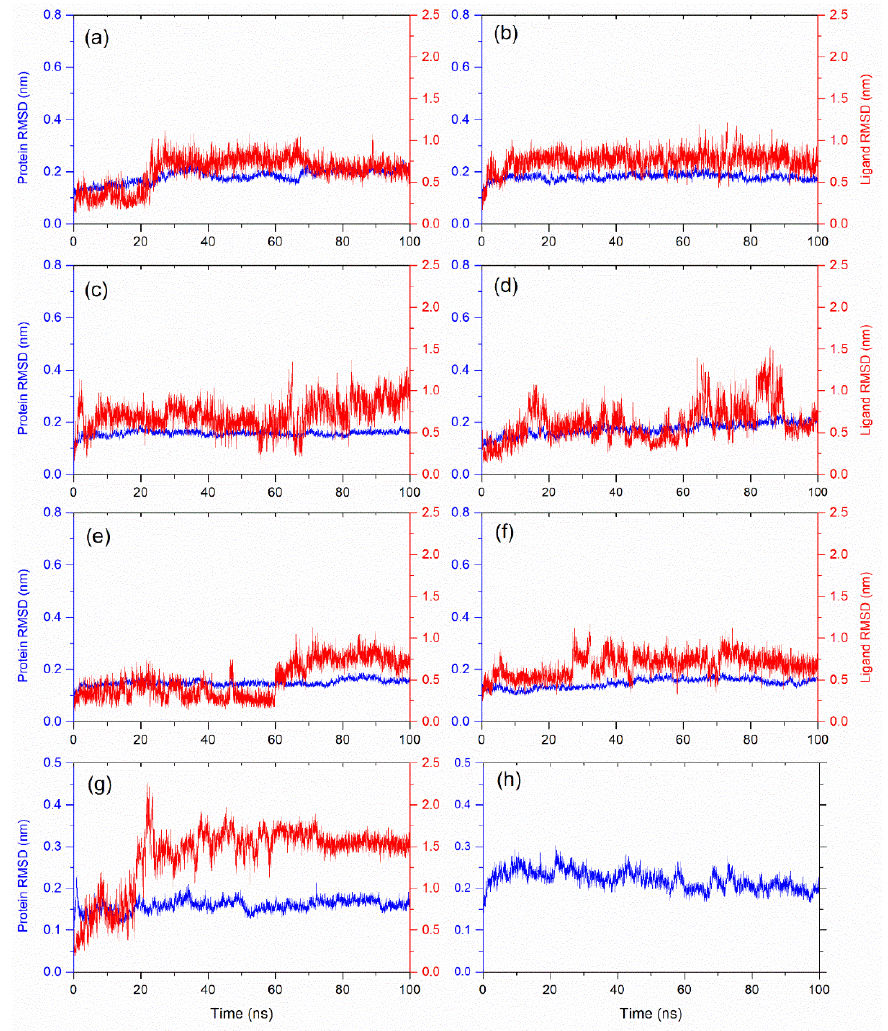
Figure 2. Root mean square deviation (RMSD) of protein and ligand for the docked poses obtained from 100 ns MD simulation for ( a ) Catechin 3,7,-Di- O -Galate, ( b ) Catechin 5,7,-Di- O -Gallatec, ( c ) Catechin 5,4 ’ -Di- O -Gallate, ( d ) Epifisetinidol-(4beta->8)-Catechin, ( e ) Catechin 3- O -Rutinoside, ( f ) Epicatechin (4b->6) Catechin, ( g ) L44 inhibitor and ( h ) apo-protein . Cα atoms of protein were used for RMSD calculation (blue), and ligand RMSDs (red) were calculated for heavy atoms by fitting the protein-ligand complex.